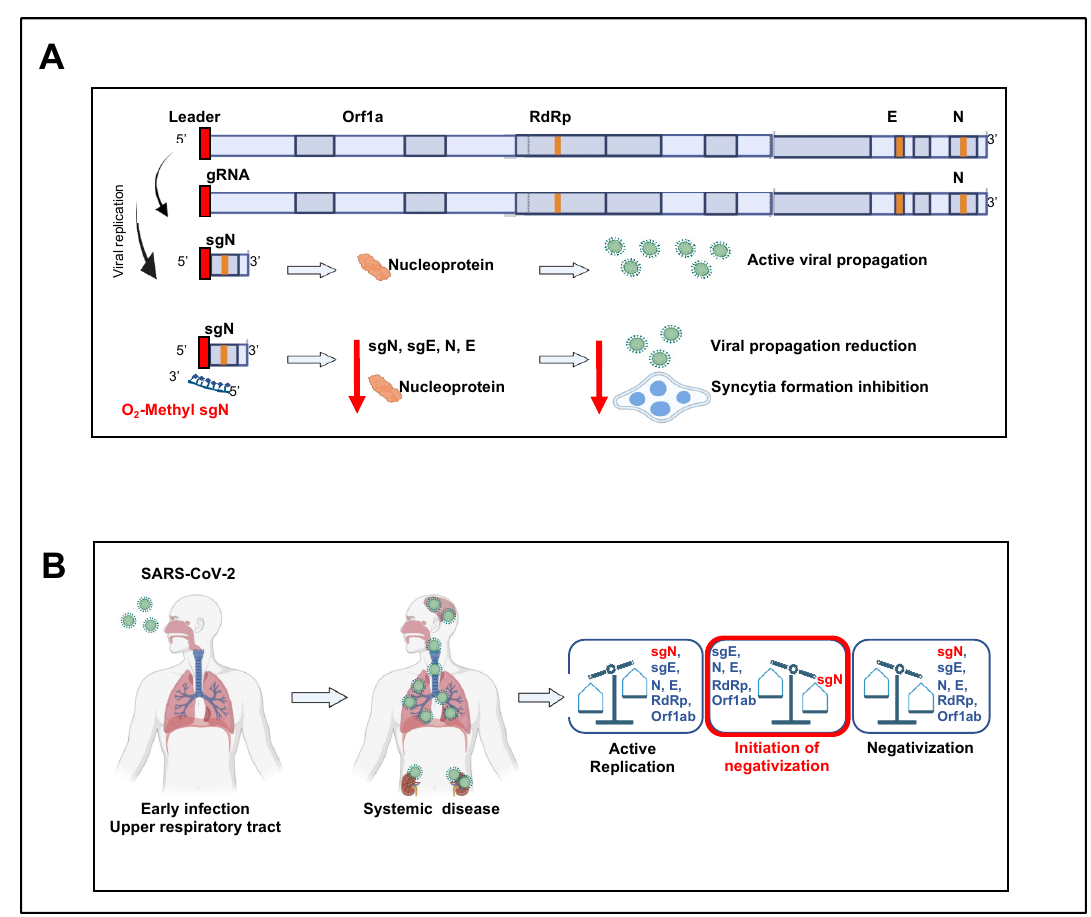
Figure 5. Proposed mechanism of action of sgN during infection by SARS ‐ CoV ‐ 2. ( A ) The biogenesis of subgenomic RNAs follows the “leader to TRS ‐ B fusion model”, which produces copies of sgN that are translated to the N protein. Impairment of this process through 2’ ‐ O ‐ methyl antisense RNA against sgN results in therapeutic benefits in terms of decreased viral replication and syncytia formation in vitro. ( B ) During SARS ‐ CoV ‐ 2 infection, the acute phase of virus replication is enhanced by expression of viral genome and subgenomic transcripts; while during the negativization process, the loss of sgN detection is seen (i.e., undetectable levels: Cq > 40; viral ORF1ab and E Cq values > 33.15 and 33.16, respectively).